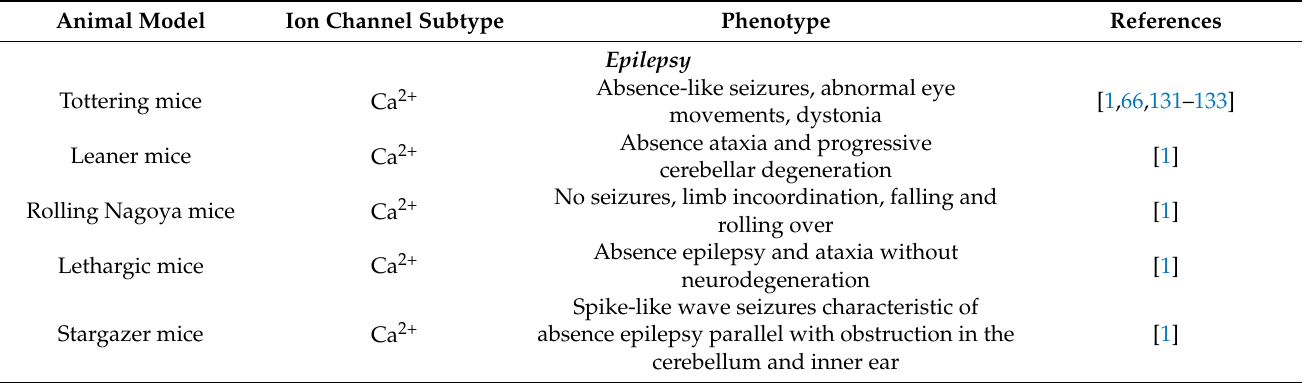
Table 3. Summary of rodents’ models of CNS